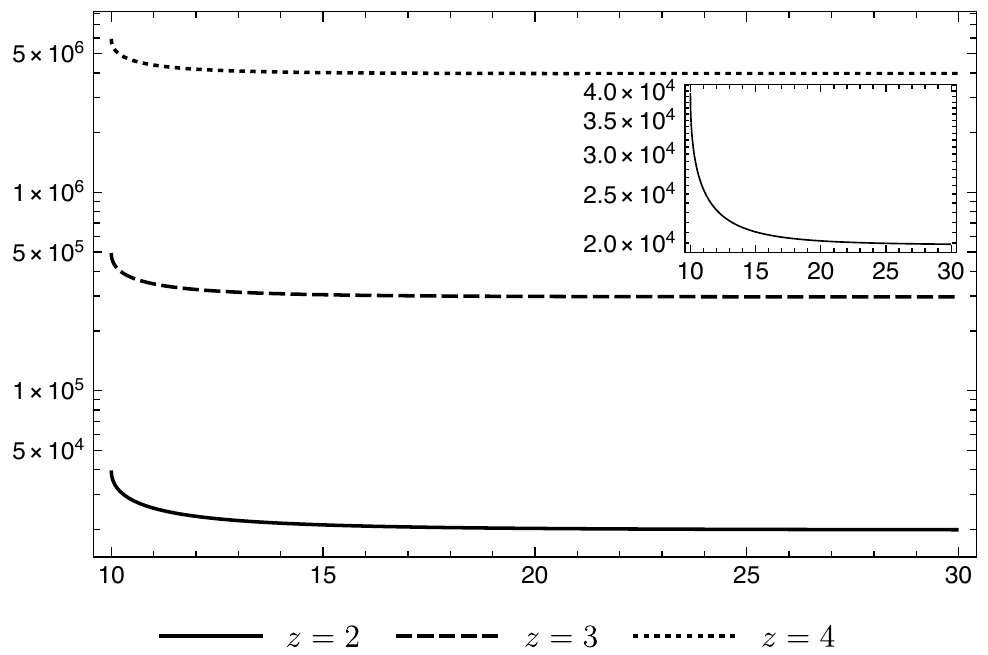
Figure 4 . The figure illustrates the Π x x = Π y y components of the black holes with R 0 = 10 . The smaller figure is a close up to demonstrate the behaviour for z = 2